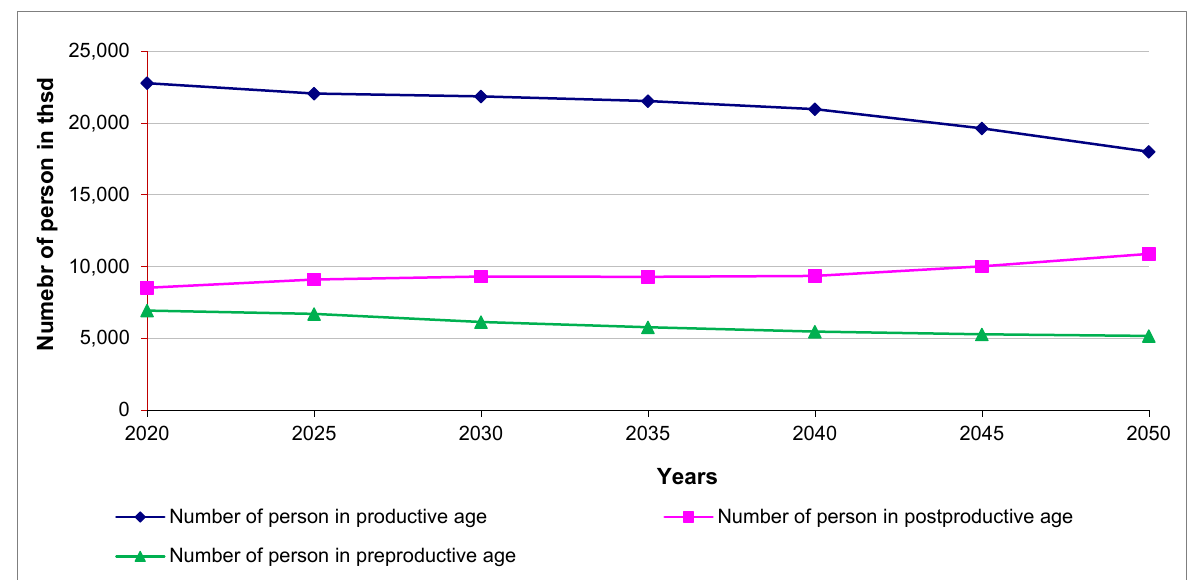
Figure 6. Official prognosis of the number of people of pre-, post-, and productive age (in thsd)